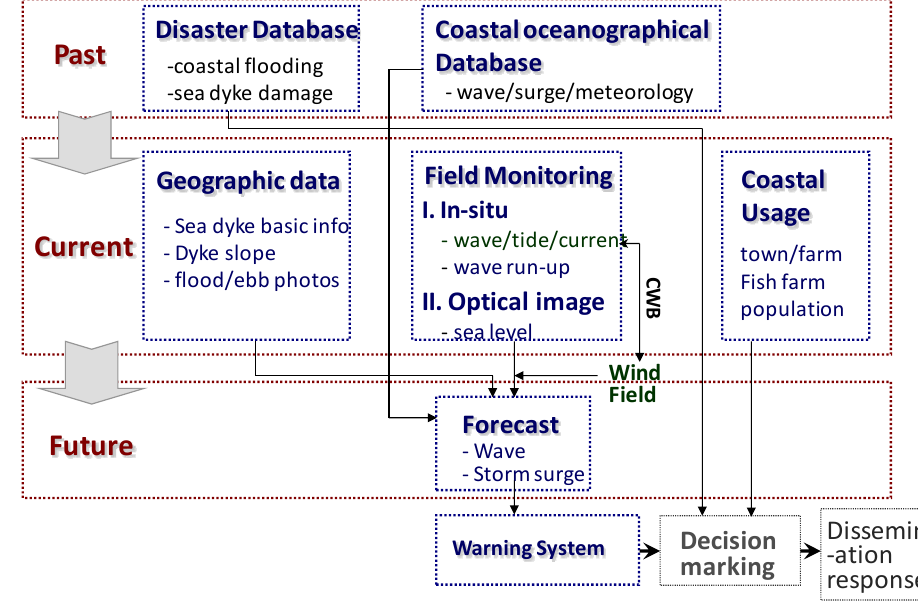
Figure 3 Framework and internal link of the coastal flooding warning system Fig. 3. Framework and internal link of the coastal flooding warning system. Table 1. Composition of the monitoring